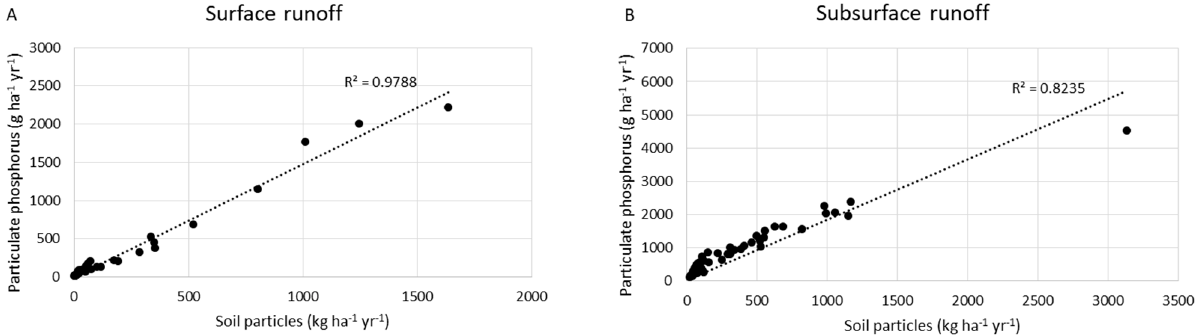
Figure 4. Relationship between annual soil (kg ha − 1 ) and particulate phosphorus loss (g ha − 1 ) for surface and subsurface runoff from single plots.